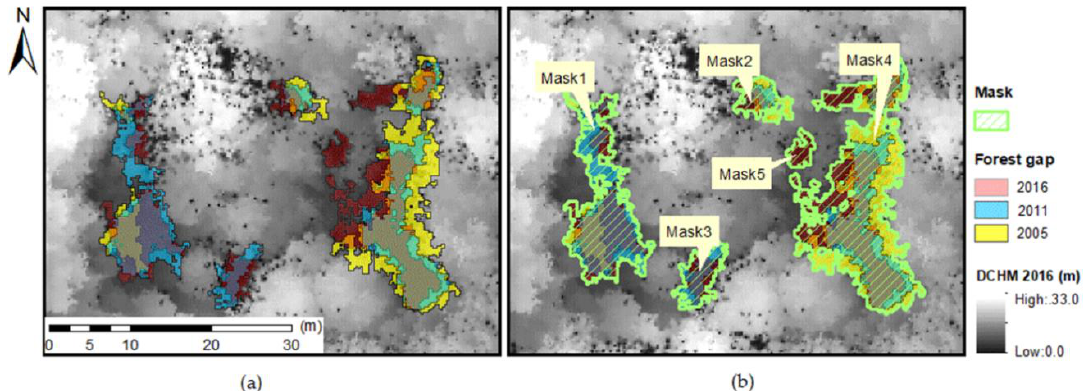
Figure 3. Gap mask showing gap interactions between 2005 and 2016. ( a ) Gap overlap between the three digital canopy height models; ( b ) masks covering interacting gaps.